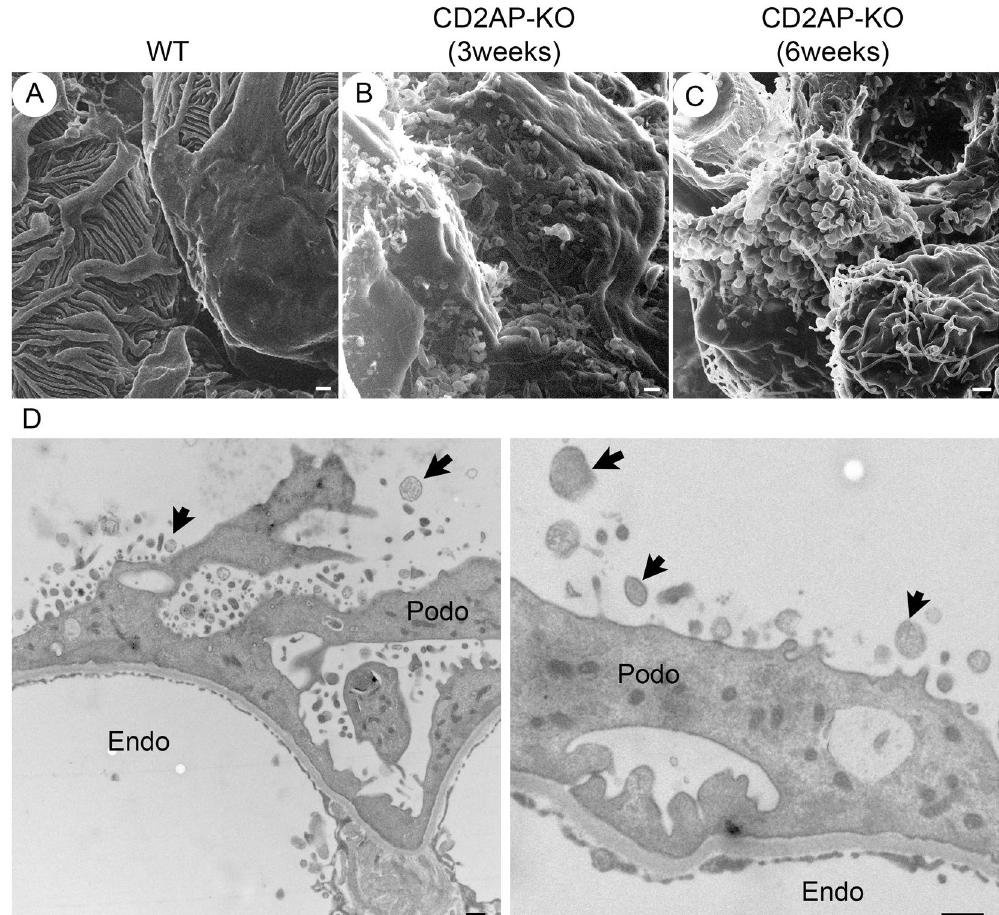
Figure 5. Bleb-like microprojections from podocytes in CD2AP deficient mice. HIM images of podocyte cell body in WT ( A ), 3 week-old Cd2ap -KO ( B ), and 6 week-old Cd2ap -KO mice ( C ). The image of WT podocytes ( A ) shows a smooth podocyte cell body and well-organized interdigitating foot processes. Images of 3 and 6 week-old Cd2ap -KO podocytes ( B , C ) reveal numerous “bleb-shaped” microprojections with a diameter of 200–